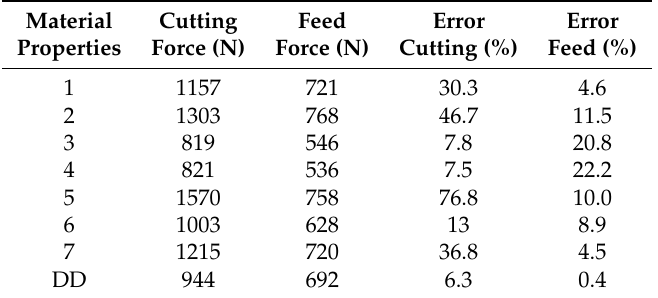
Table 7. Numerical results at 60 m/min and a feed of 0.15 mm (Experiment 4). Error is measured with respect to experimental results presented in Table 5 using Equation (22). DD is an abbreviation for the dislocation density